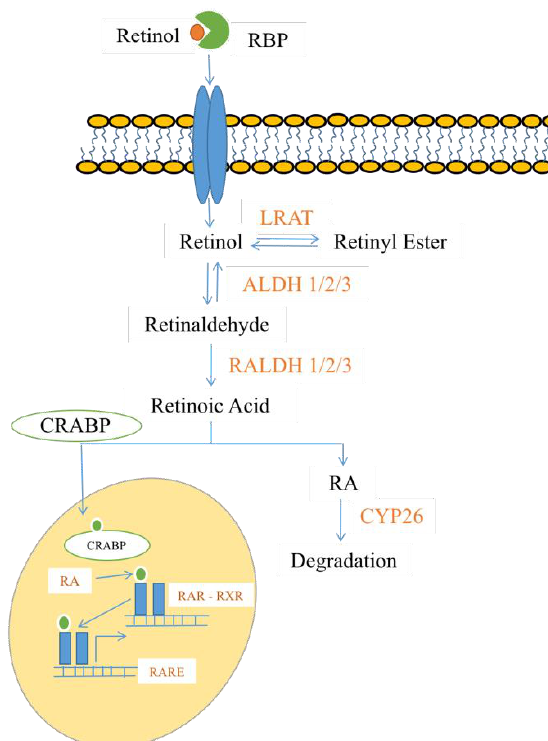
Figure 2. Mechanism of retinoic acid signaling. Upon reaching its target tissue, retinol is released from RBP and enters cells through specialized receptors. Once inside the cell, retinol can be stored as retinyl esters or irreversibly metabolized to retinoic acid by retinaldehyde dehydrogenase enzymes through a retinaldehyde intermediate. Bioactive RA enters the nucleus bound to CRABP and activates a RAR-RXR heterodimer, leading to transcription of RAREs. When no longer needed, RA is degraded by CYP26 enzymes and cleared from the body. Abbreviations: ALDH, aldehyde dehydrogenase; CRABP, cellular retinoic acid-binding protein; CYP26, family 26 of cytochrome P450 enzymes; LRAT, lecithin retinol acyltransferase; RA, retinoic acid; RALDH, retinaldehyde dehydrogenase; RAR, retinoic acid receptor; RARE, retinoic acid response element; RBP, retinol-binding protein; RXR, retinoid X receptor.